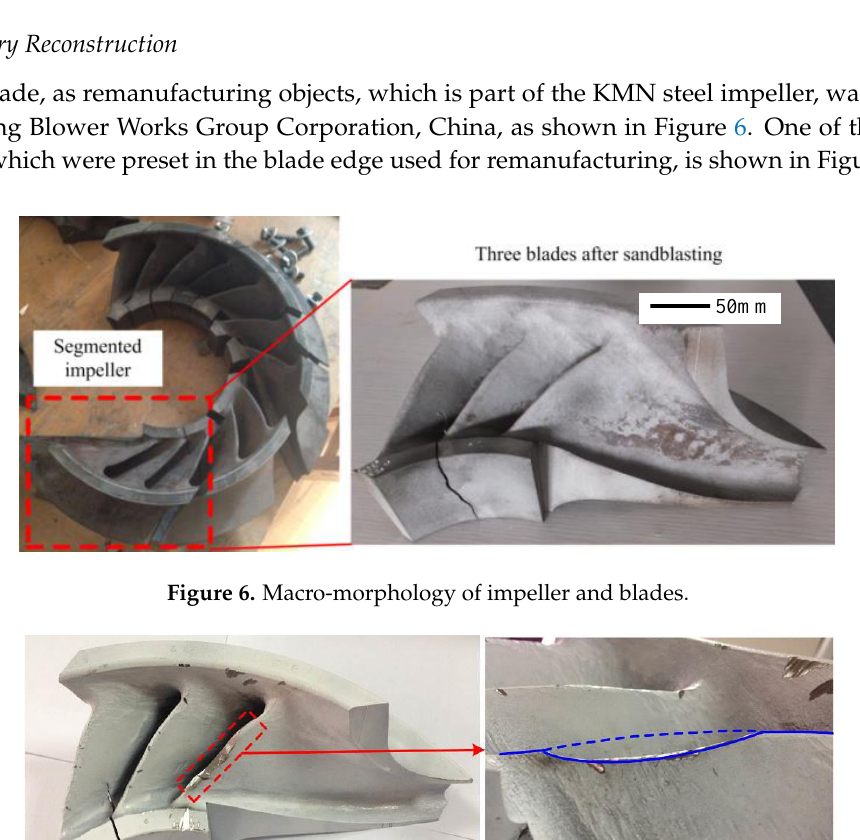
Figure 6. Macro-morphology of impeller and blades.